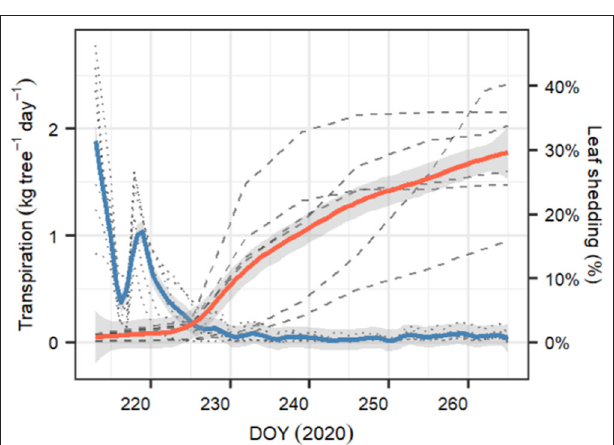
FIGURE 5 | Temporal evolution of whole-tree transpiration (in kg tree − 1 day − 1 ) and percent of leaf shed for the six monitored P. sylvestris saplings growing in the greenhouse during the whole length of the experiment (DOY 212–265). Blue line represents the average daily transpiration ± 1 SD, whereas red line represents the daily cumulated percent of leaf shed since the beginning of the experiment ± 1 SD. Transparent dotted lines are the observed daily transpiration for each tree, and transparent dashed lines are the cumulated percent of leaf shed for each